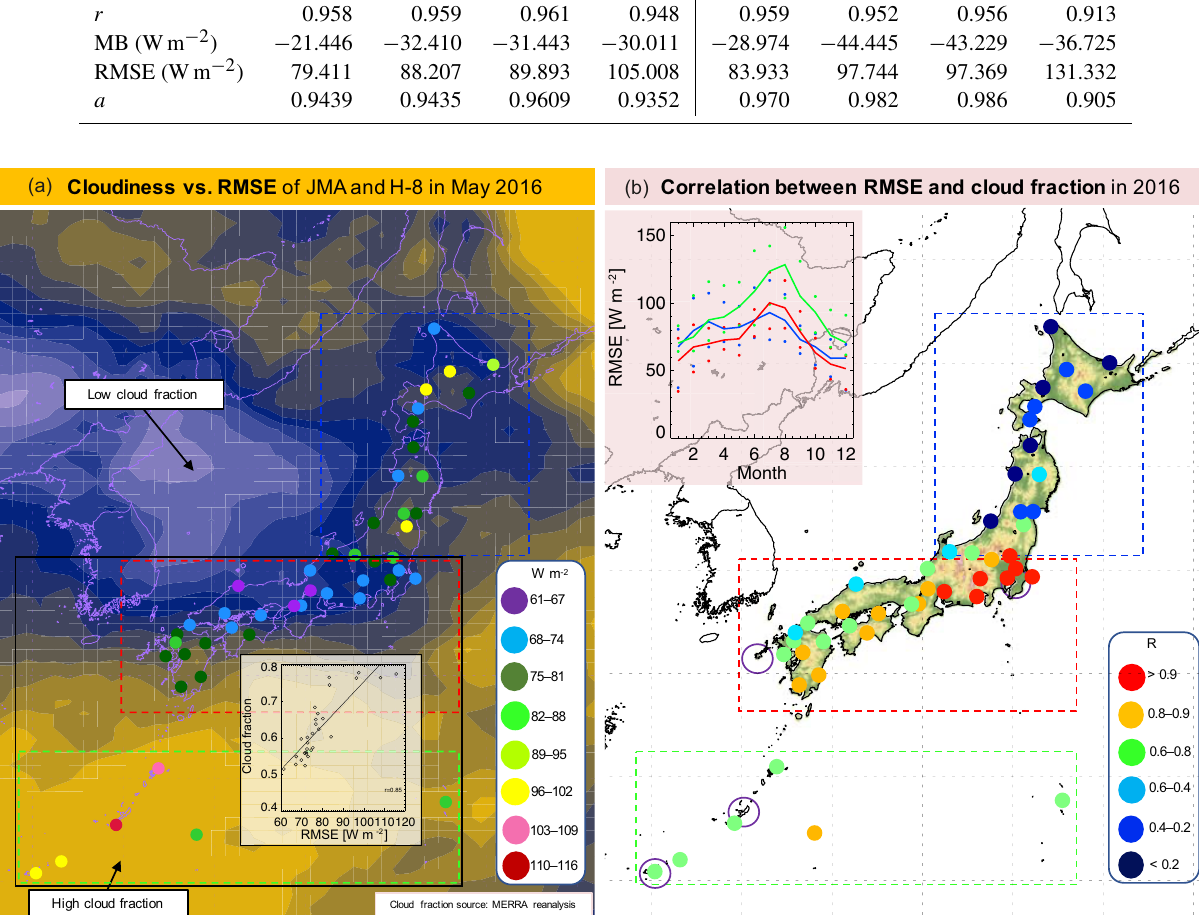
Figure 3. (a) Influence of cloudiness (i.e., total cloud fraction, violet to yellow contour map) on the monthly RMSE of ground observations and Himawari-8 estimates of solar radiation at the 47 stations (points) in the Japanese Meteorological Agency (JMA) network in May 2016. Bottom inset: scatter plot of the total cloud fraction and RMSE for the stations in the central and south regions (i.e., within the area delimited by the black line). (b) Correlation between monthly RMSE and cloud fraction at each JMA station for 2016 plotted over the Japan Digital Elevation Model derived from GTOPO-30 (https://lta.cr.usgs.gov/GTOPO30). The three main regions, i.e., north, central, and south, are enclosed by blue, red, and green dashed lines, respectively; violet circles show the location of the SKYNET stations; inset: mean RMSE (bold lines) and minimum and maximum RMSE (points) for the different regions for December to January 2016.